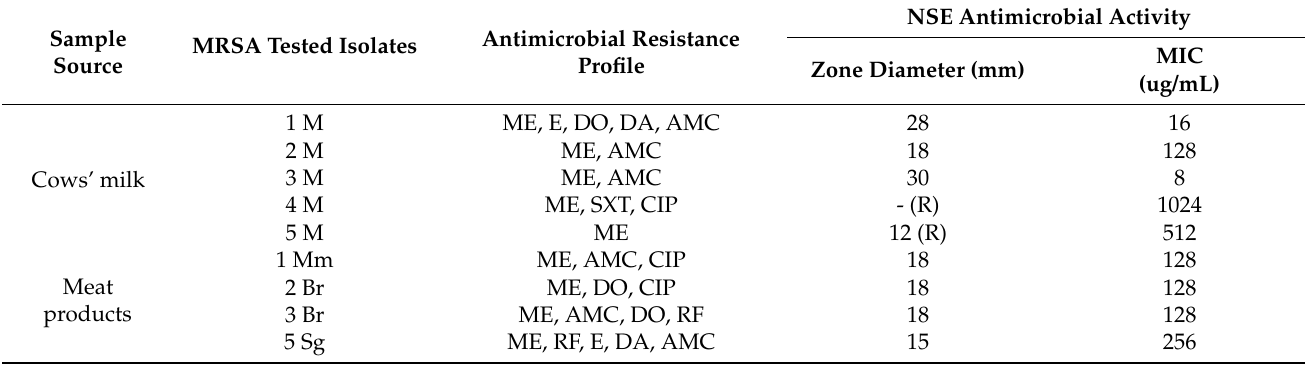
Table 3. Susceptibility of resistant MRSA isolates from cows’ milk and meat products to